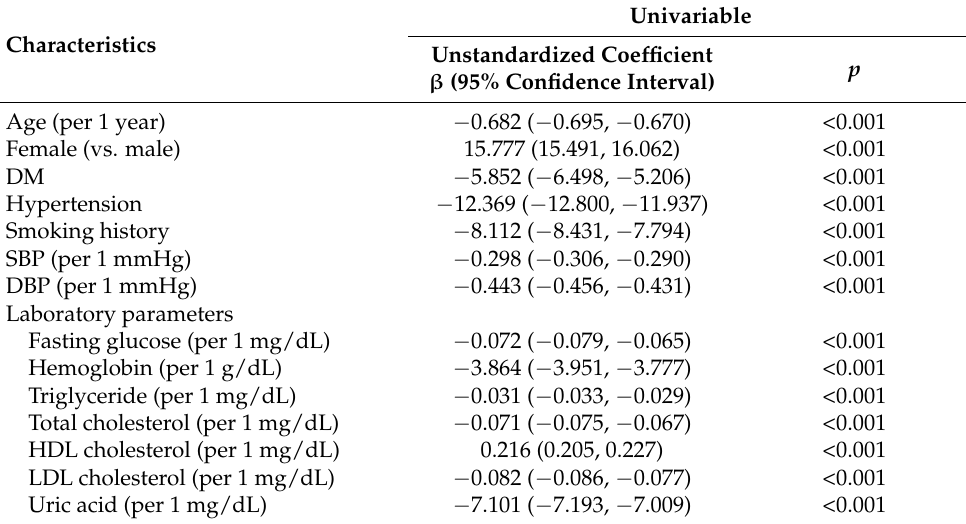
Table 3. Determinants for baseline eGFR using univariable linear regression analysis in all study participants ( n = 122,068).